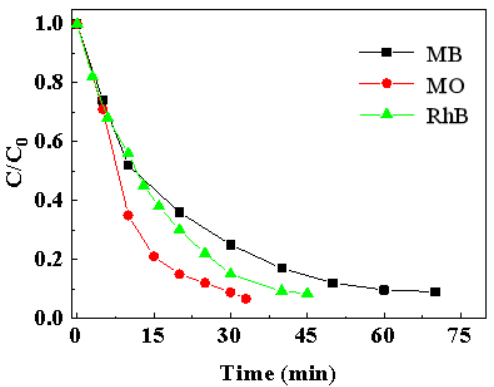
Figure 4. Adsorption kinetic curves of ZnO on MO, MB and RhB dyes.